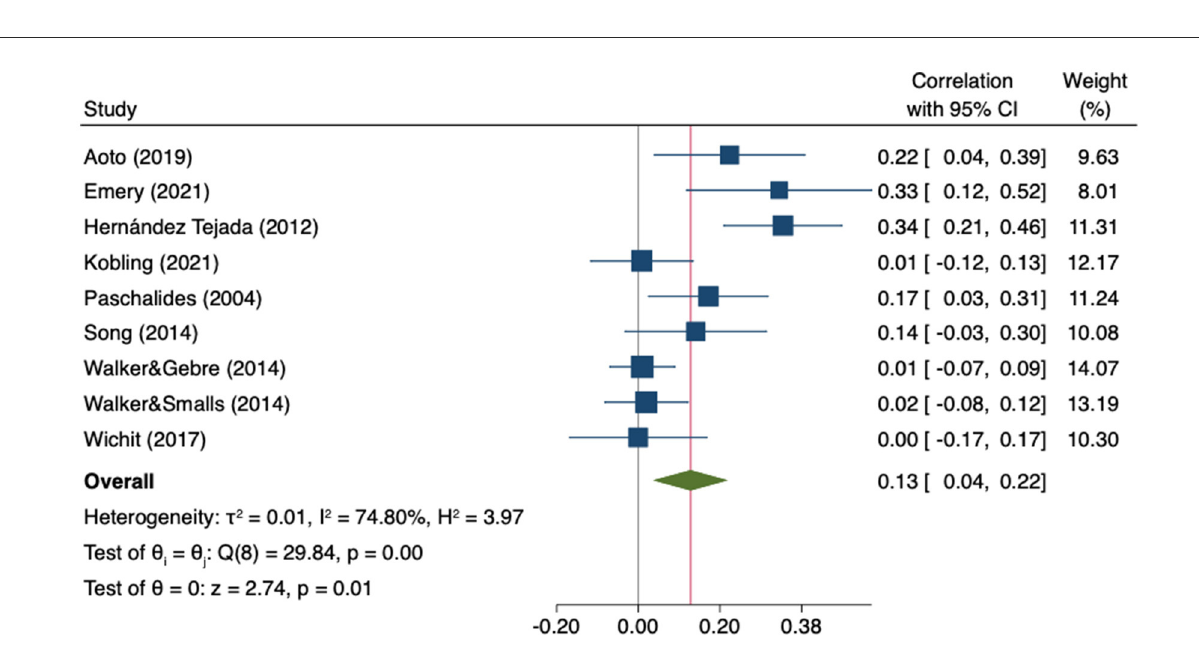
FIGURE13 Random-effects meta-analysis on the association between empowerment and physical